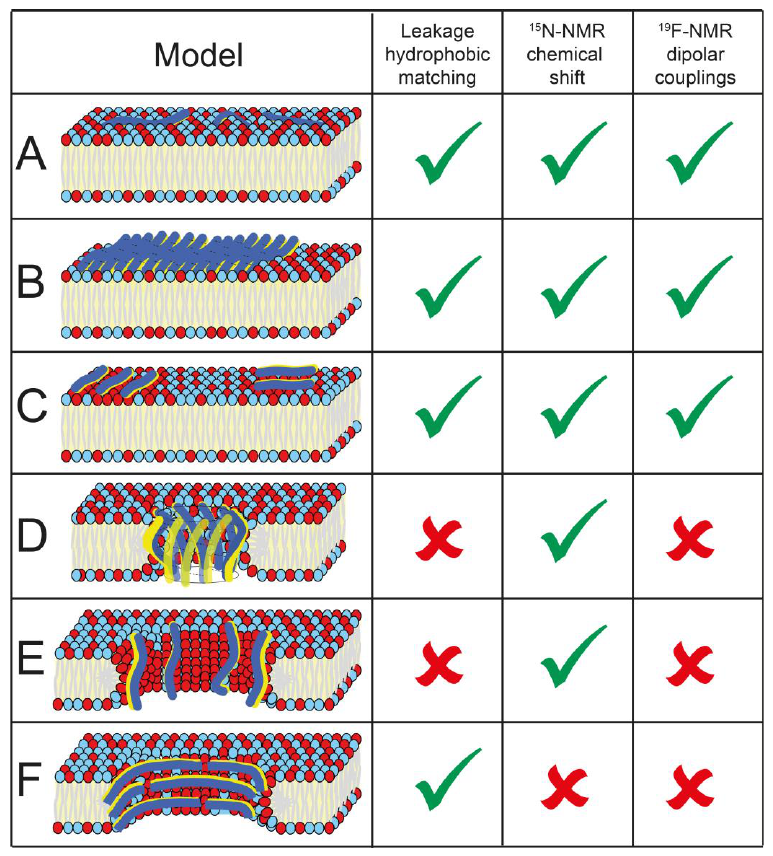
Figure 7. Compatibility of the different hypothetical models A – F from Figure 1 with our experimental data. A green tick ( ✓ ) indicates that the model is consistent with the data, while a red cross ( ) means that the model has to be rejected due to inconsistency with the data. These results from the antimicrobial and hemolytic assays, as well as vesicle leakage tests, indicate that long KL peptides are intrinsically active when bound to the membrane.